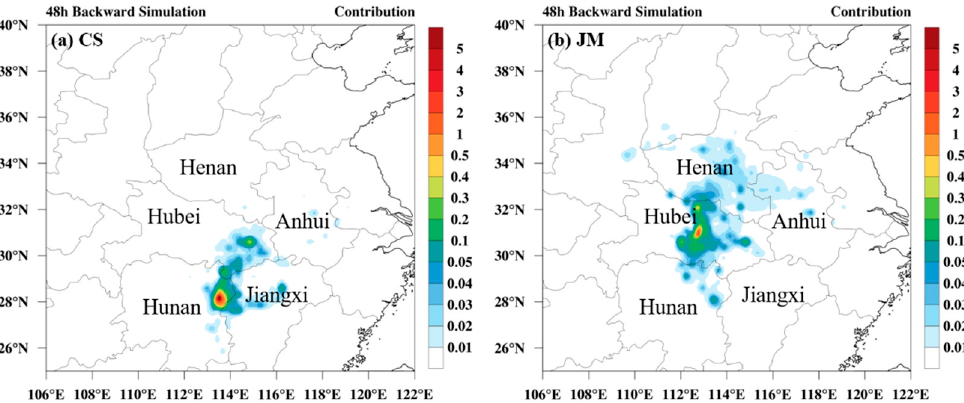
Figure 10. Distributions of contribution rates (units: %) to PM 2.5 concentrations in ( a ) CS and ( b ) JM for winters from 2016–2020 simulated by the WRF-FLEXPART model.